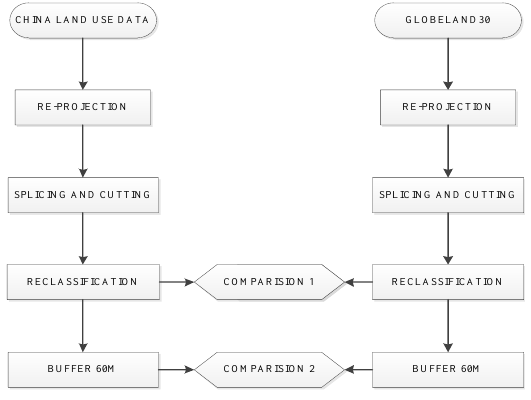
Figure 1. The flow chart of data processing